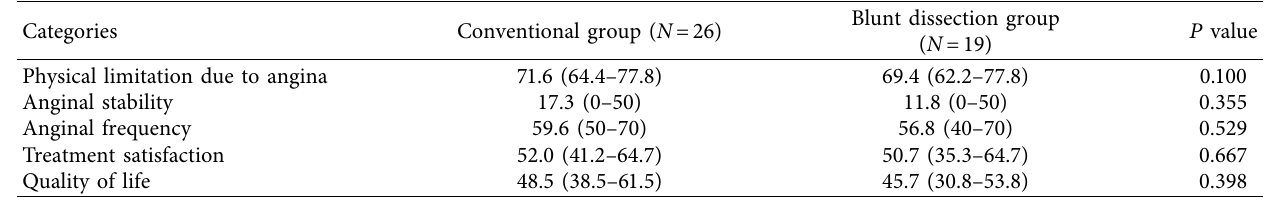
Table 5: Seattle Angina Questionnaire Scores before unroofng operation in the two groups.